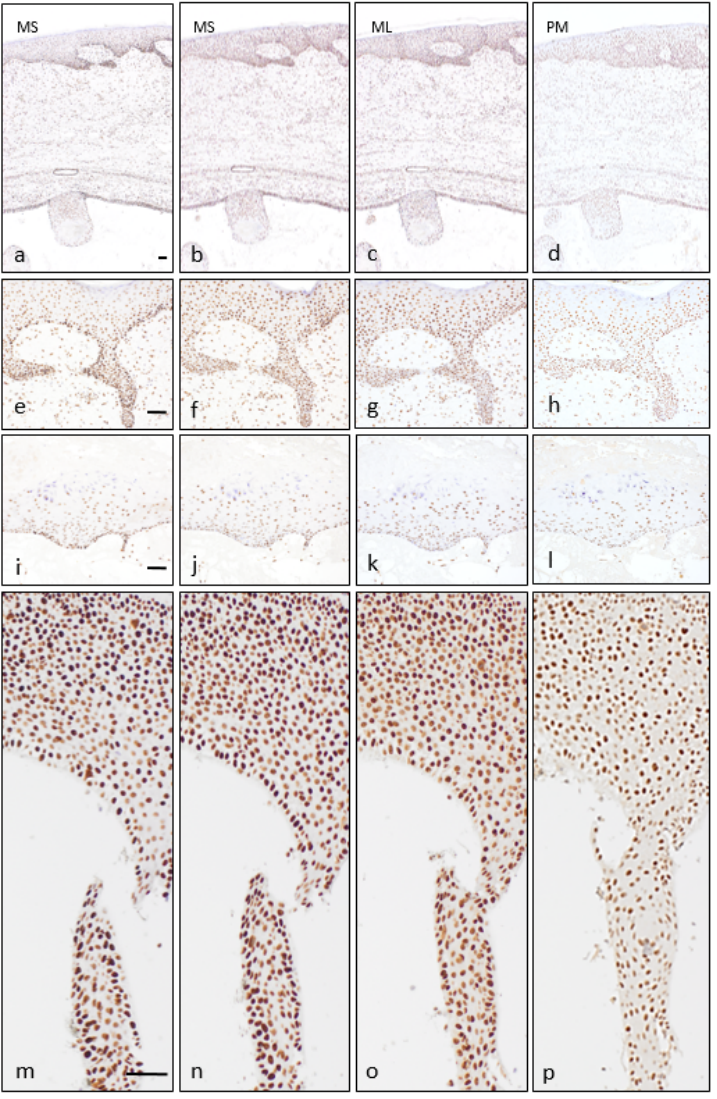
Figure 3. Mismatch repair protein expression. There are depicted immunohistochemical results for MSH6 ( a , e , i , m ), MSH2 ( b , f , j , n ), MLH1 ( c , g , k , o ) and PMS2 ( c , h , l , p ) in different regions of Case 1 to illustrate their variability. Tumour can be identified in the inferior part of the image, with slightly hyperplastic overlying skin ( a–d ). On a detailed view, overlying skin displayed widespread nuclear expression with positive control in dermal inflammatory cells ( e – h ). On the tumour there were present areas with reduced nuclear expression in the thinnest epithelial lining with focal hypergranulosis ( i – l ), contrasting with the increased expression in proliferative areas ( m – p ). Scale bars ( a – d , e – l , m – p ): 50 µ